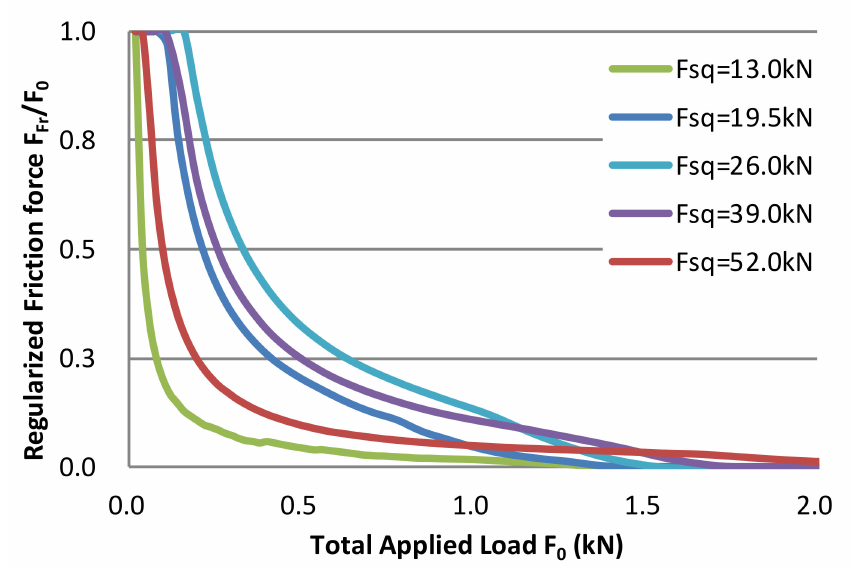
Figure 9. Ratio of frictional force to total transferred load of the single-row